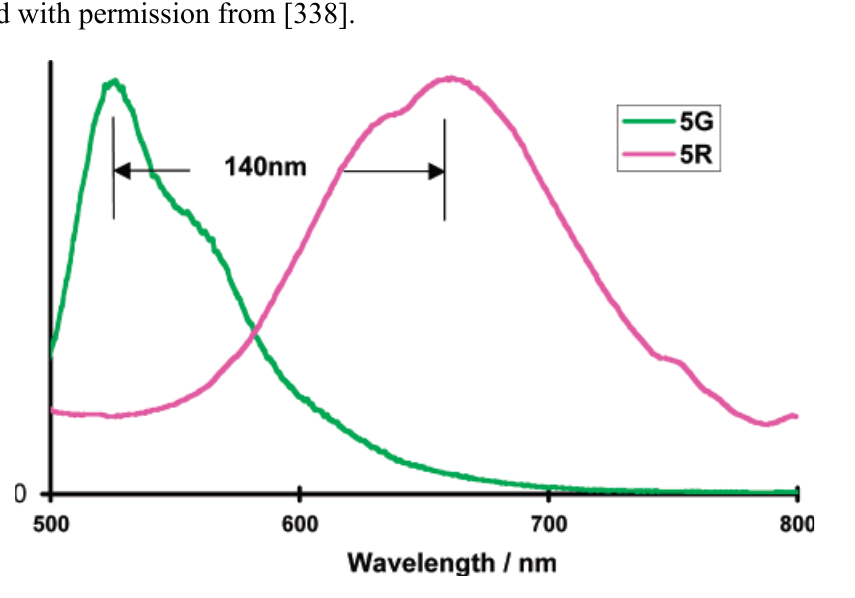
Figure 9. Emission spectra of 5-R and 5-G at 298 K in the solid state (4% in KBr). Reproduced with permission from